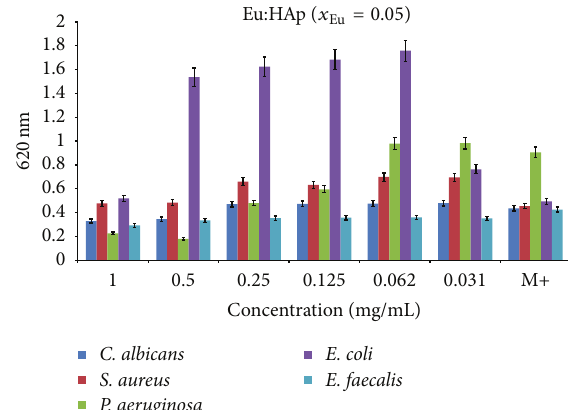
Table 1: IR wavenumber position (cm − 1 ) of ] 4 , ] 3 , ] 2 , and ] 1 [ PO 4 ] 3−